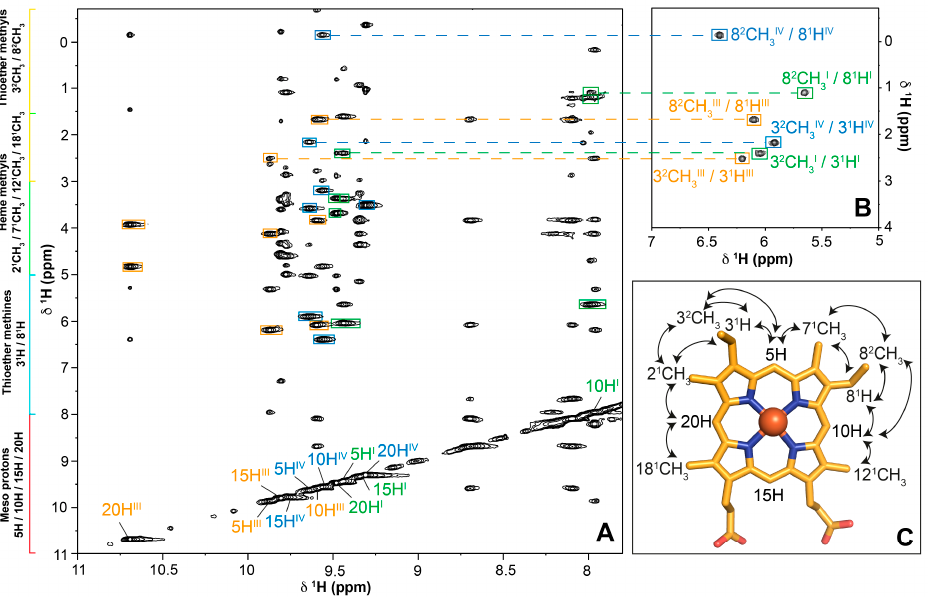
Figure 4. Illustration of the methodology used to assign the heme proton’s signals of domain D in the reduced state. ( A ) Expansion of a 2D 1 H-NOESY NMR spectrum (80 ms mixing-time) region intraheme NOE connectivities for the heme meso protons. The typical regions for the heme proton signals are highlighted on the left of the spectrum; ( B ) Expansion of the 2D 1 H-TOCSY NMR spec- trum (50 ms mixing-time) highlighting the thioether methine/thioether methyls scalar coupling. The dashed lines connect the thioether methyl’s signals with the corresponding meso proton in the 2D 1 H-NOESY NMR spectrum; ( C ) Diagram of heme c numbered according to the IUPAC-IUB nomen- clature [46]. The full lines represent the interheme NOE connectivities. The spectra were recorded at pH 8 and 288 K on a spectrometer operating at a proton frequency of 600 MHz.